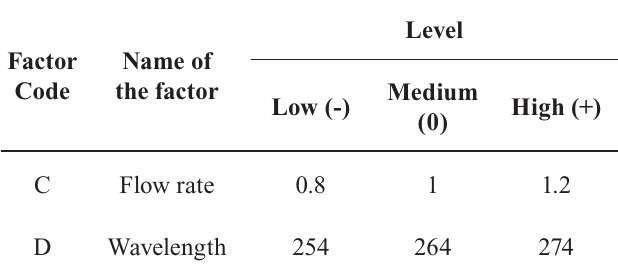
TABLE I - E xperimental factors and levels used in the